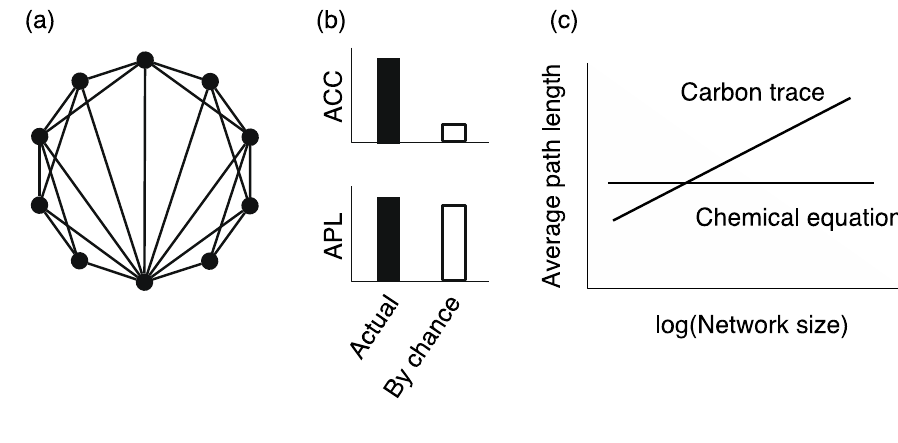
Figure 6. (a) Schematic diagram of small-world metabolic networks. (b) In general, the small-world properties are defined according to the statistical significance of the average clustering coefficient (ACC) and average path length (APL). (c) The network size dependency of APL is different between network